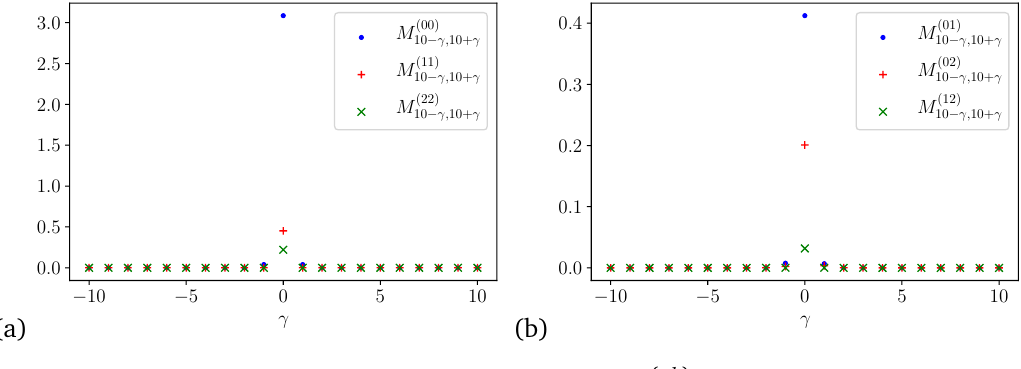
Figure 9: Anti-diagonal cut of occupation numbers M cut corresponds to α = 10 + γ and β = 10 − γ . The chosen parameters are the same as in Fig. 6.